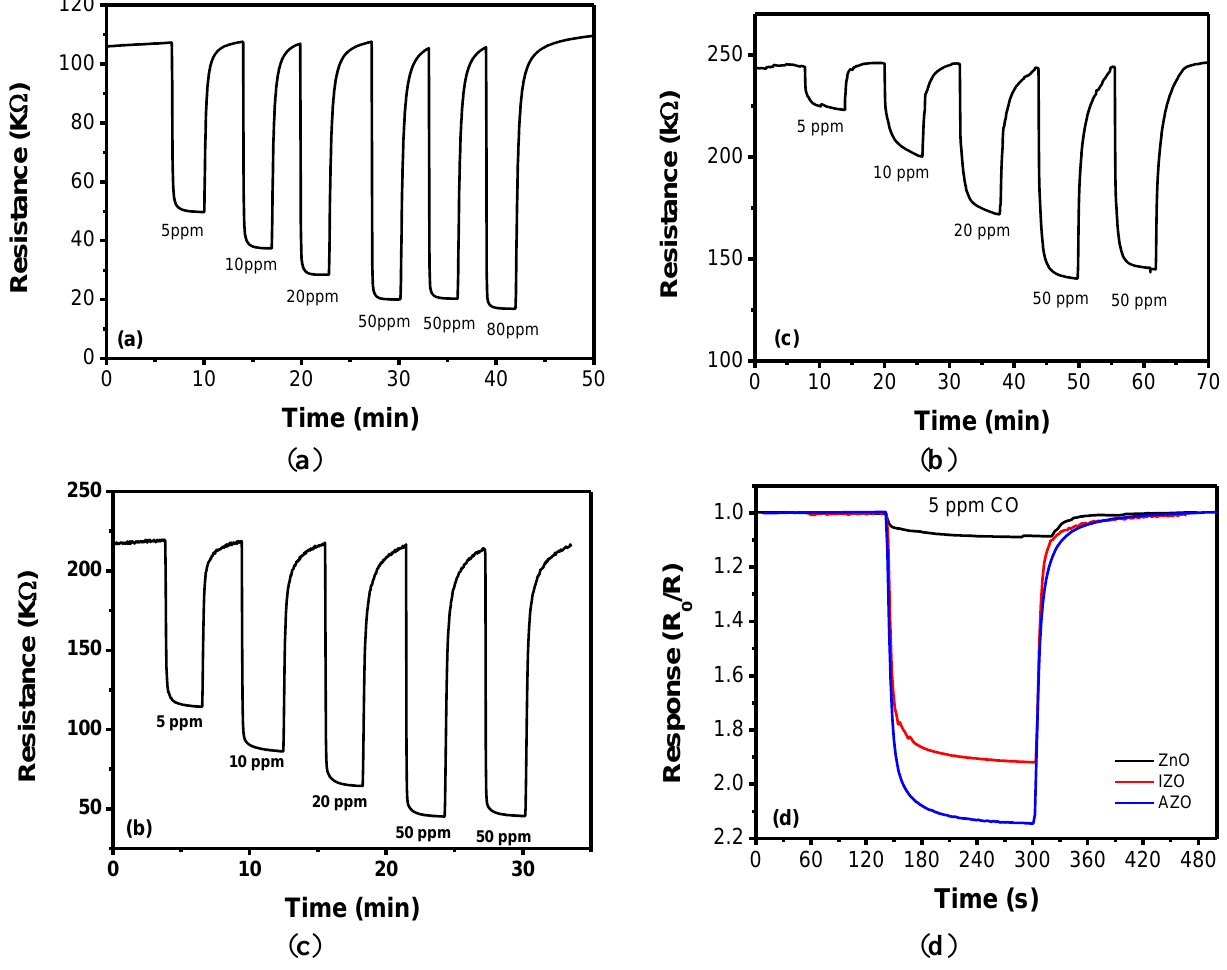
Figure 4. Transient responses of the sensors tested to different CO concentrations in air at the operating temperature of 300 °C. ( a ) AZO; ( b ) IZO; ( c ) ZnO; ( d ) Dynamic response comparison.